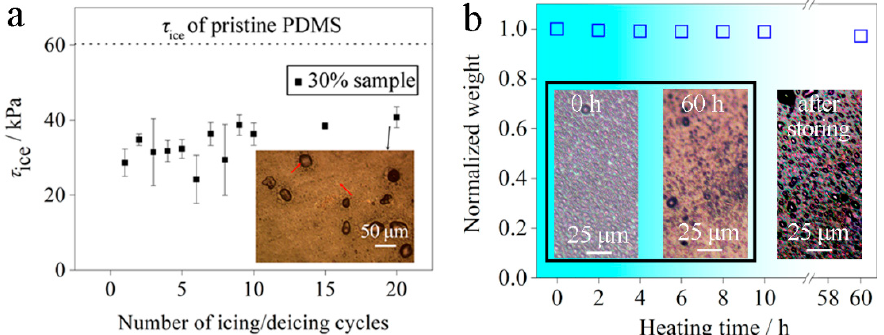
Figure 6. ( a ) Ice adhesion strengths of the optimized sample (30% coating) during the icing/deicing cyclic tests. The inset in ( a ) is the optical microscopy image of 30% coating after 20 cyclic tests. ( b ) Normalized weight loss of 30% sample at 100 ◦ C with respect to time. The insets in ( b ) are the optical microscopy images of the coatings before and after heat-treatment and then storing for 5